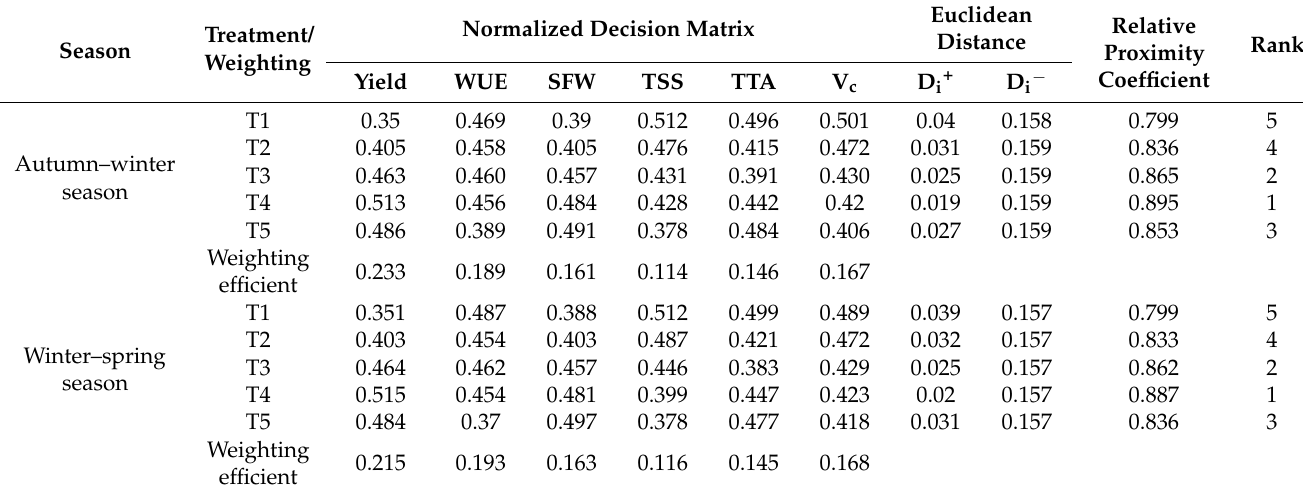
Table 6. TOPSIS-based comprehensive evaluation of irrigation amount effects on the tomato quality, yield, and